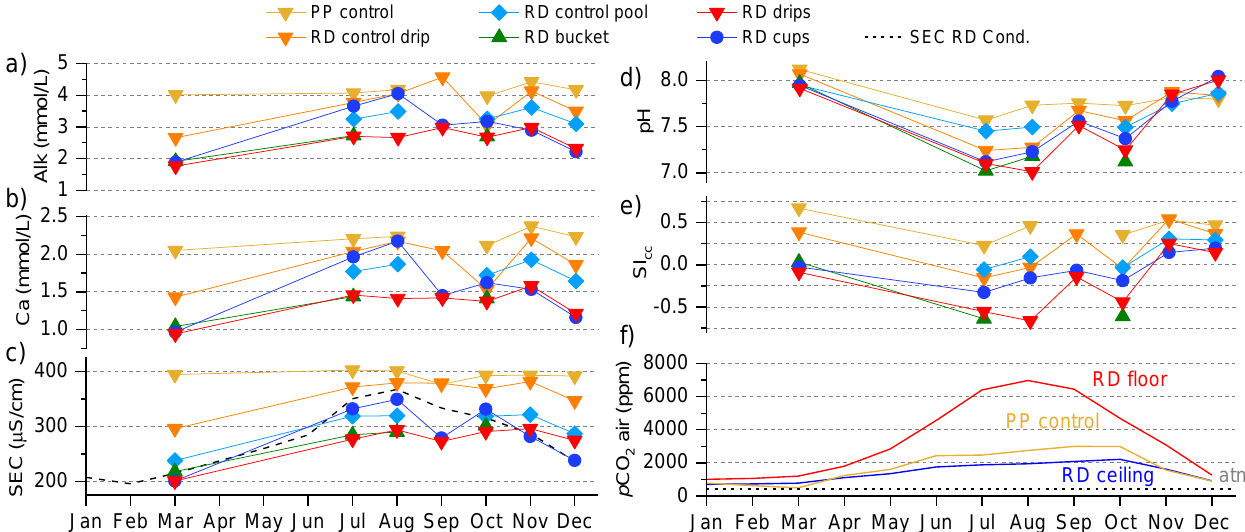
Figure 9. Collated monthly averages of the cave air and water data collected during 2017–2020. Time series of the alkalinity ( a ), Ca concentration ( b ), SEC ( c ), pH ( d ), SI cc ( e ) and cave air p CO 2 ( f ) for different sampling sites in Pisani Passage. The black dashed line in ( c ) shows the values of the continuous records from the SEC of the RD Cond. cup. Monthly p CO 2 values in Red Hall were calculated from a continuous time series for the floor and ceiling (Figure 7), while PP represents the mean p CO 2 values measured manually at the PP control sites. The horizontal black dashed line represents the atmospheric value (400 ppm).